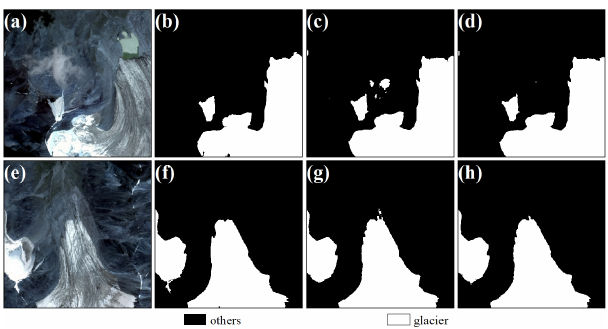
Figure 14. Demonstration of glacier extraction based on the image of 29 September 2020 (regional centroid coordinates of 35.83 ◦ N, 91.95 ◦ E). (a) The RGB image, (b) the ground truth, and (c) – (h) SBTM, RF, FCN, U-Net, DeepLab V3 + and Attention DeepLab V3 + with TTA, respectively.